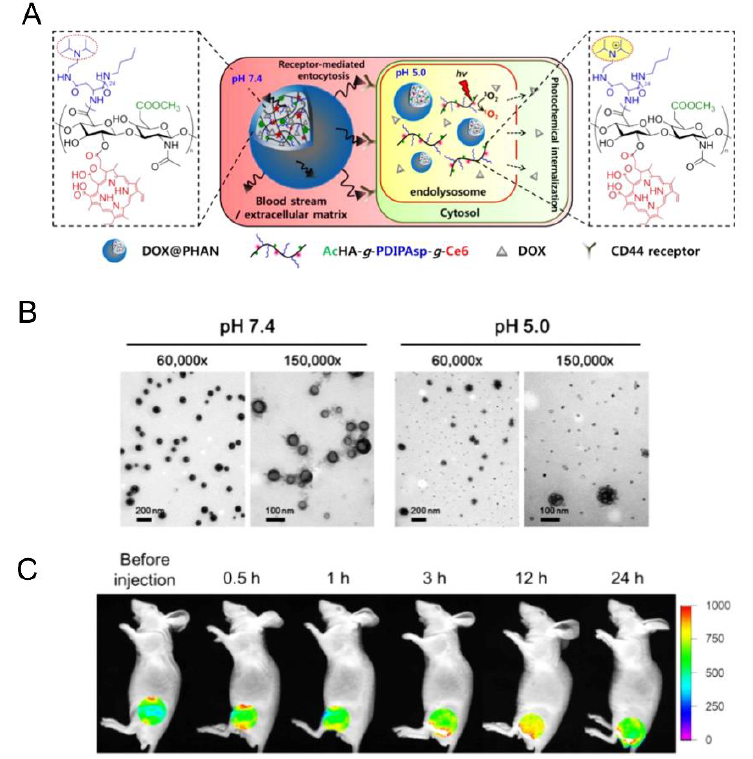
Figure 8. ( A ) Schematic representation of doxorubicin-loaded pH-responsive hyaluronic acid